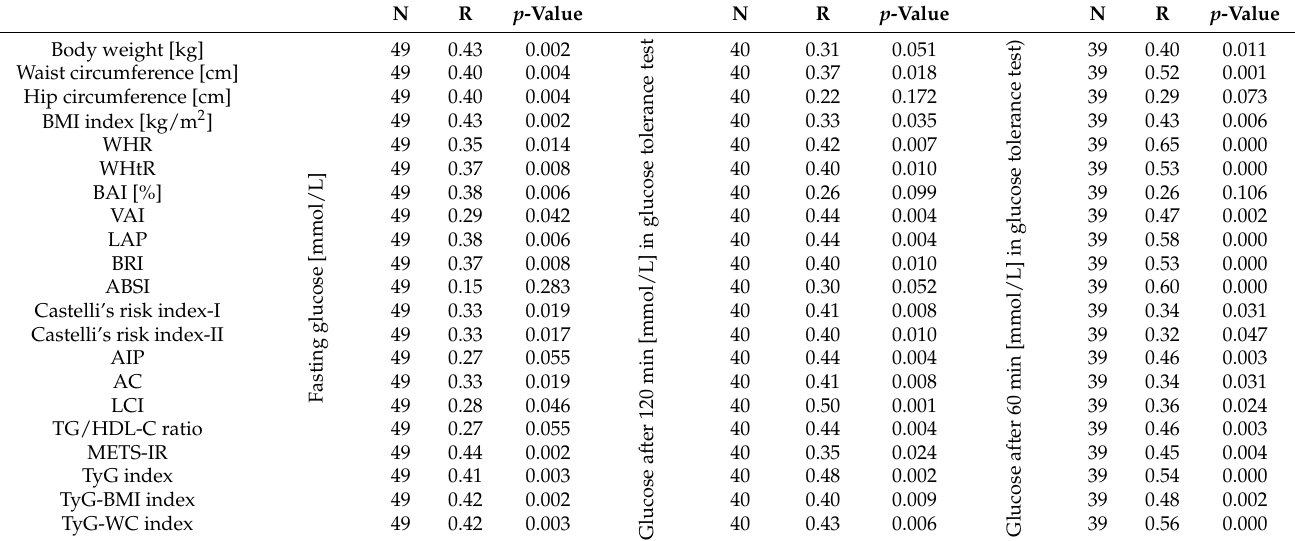
Table 2. Correlation between anthropometric parameters, atherogenic indices and glucose profile in the study